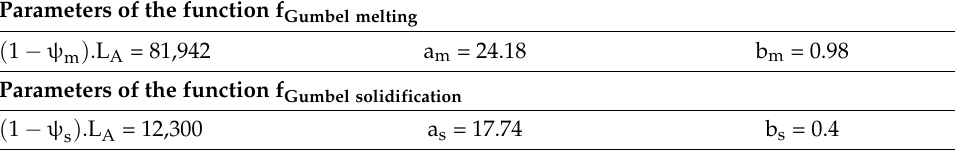
Table 5. Parameters of the Gumbel function.